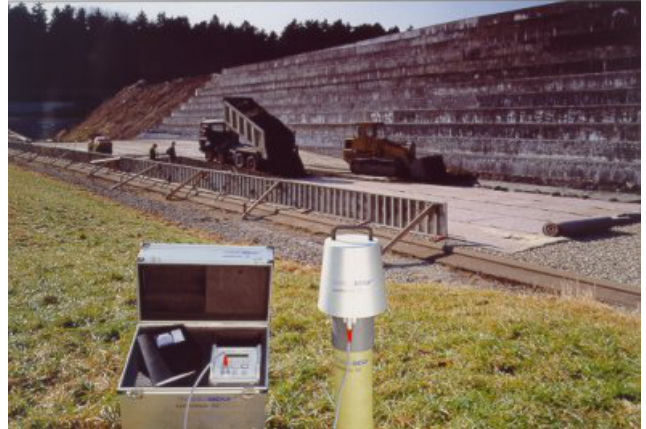
Figure 2. Commercial design of FD sensor ‘ LUMBRICUS